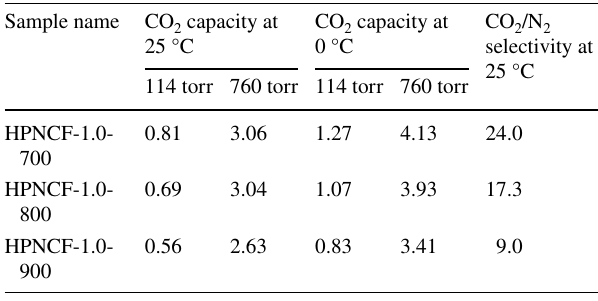
Table 2 Summary of the CO 2 capture performance of the typical